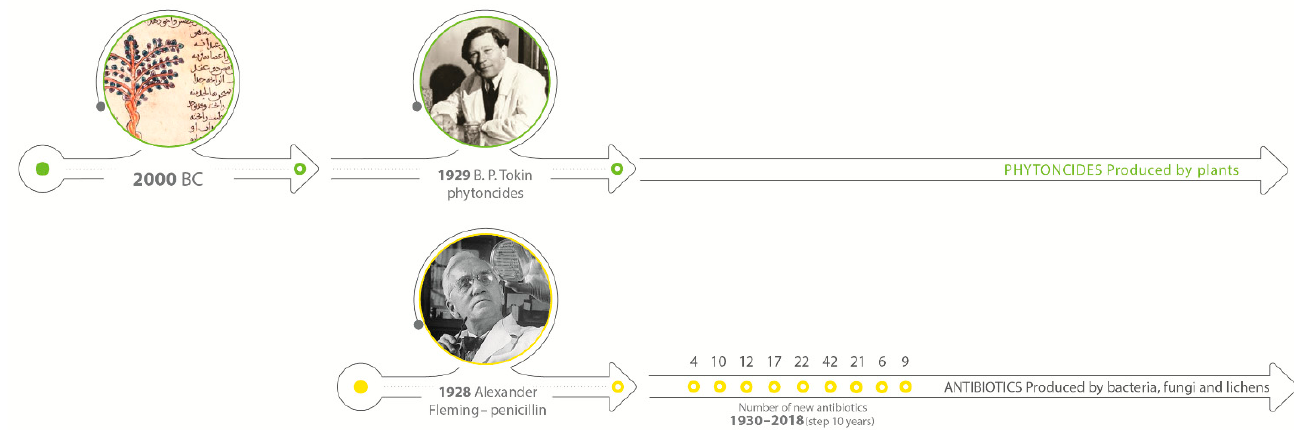
Figure 1. Timeline of antibacterial natural and synthetic compounds development.